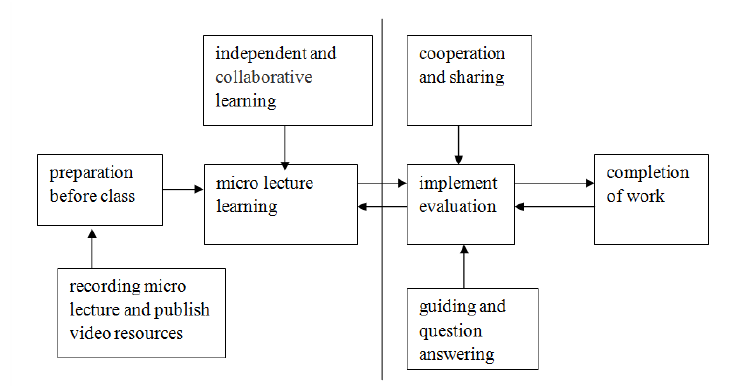
Figure 1 Teaching pattern with micro lecture